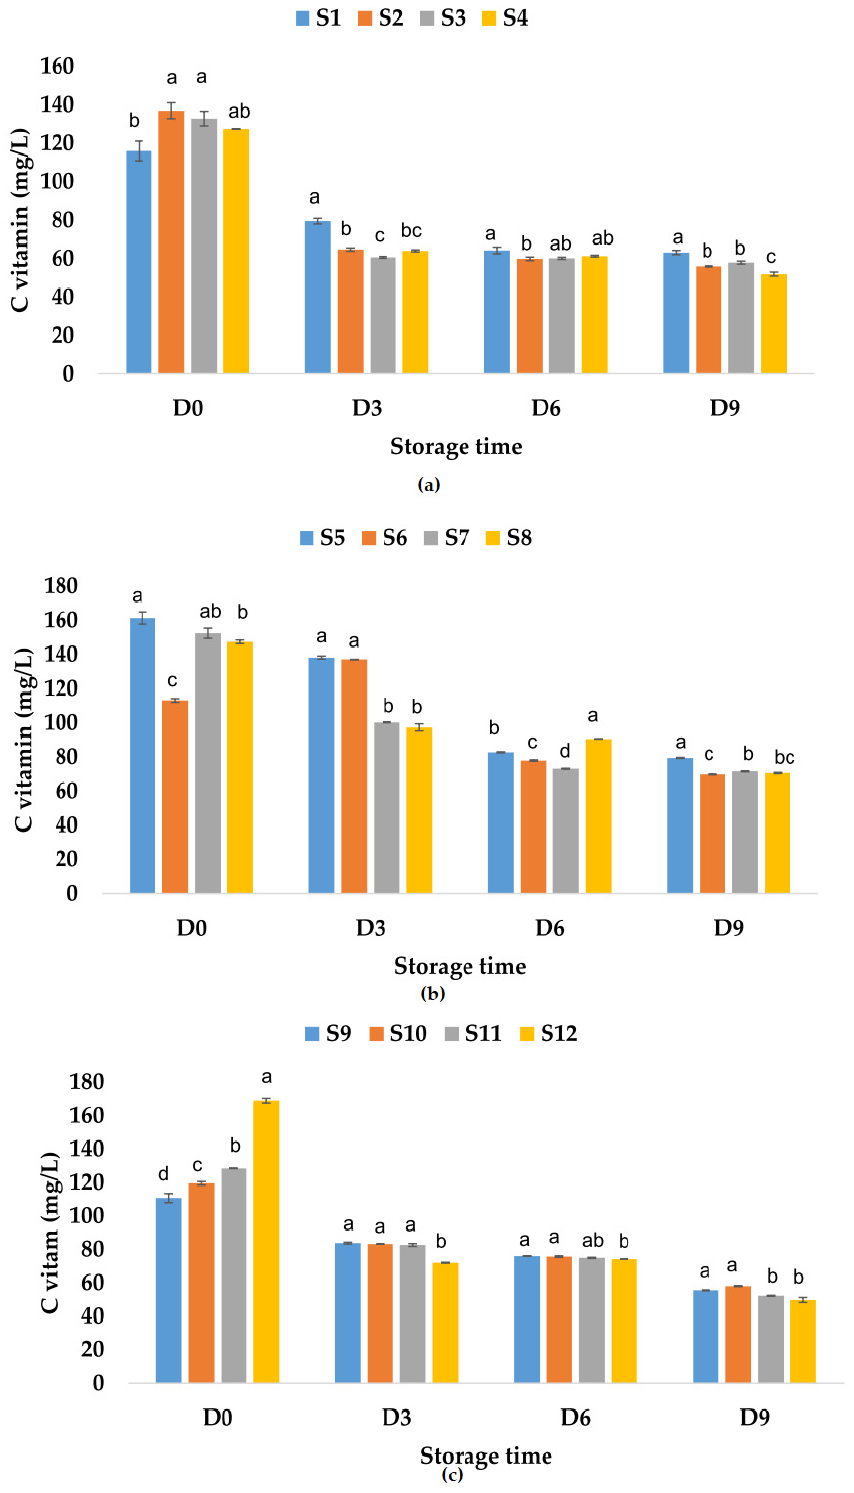
Figure 11. Variation in vitamin C (mg/L) of juice samples during the storage period (D-day) at refrigeration temperature (4 ◦ C): ( a ) apple juice samples (S1, S2, S3, S4); ( b ) apple and pumpkin juice samples (S5, S6, S7, S8); ( c ) apple and pomegranate juice samples (S9, S10, S11, S12). Means with different lowercase letter indicate the significant differences ( p < 0.05) among the samples and were performed separately for each day of